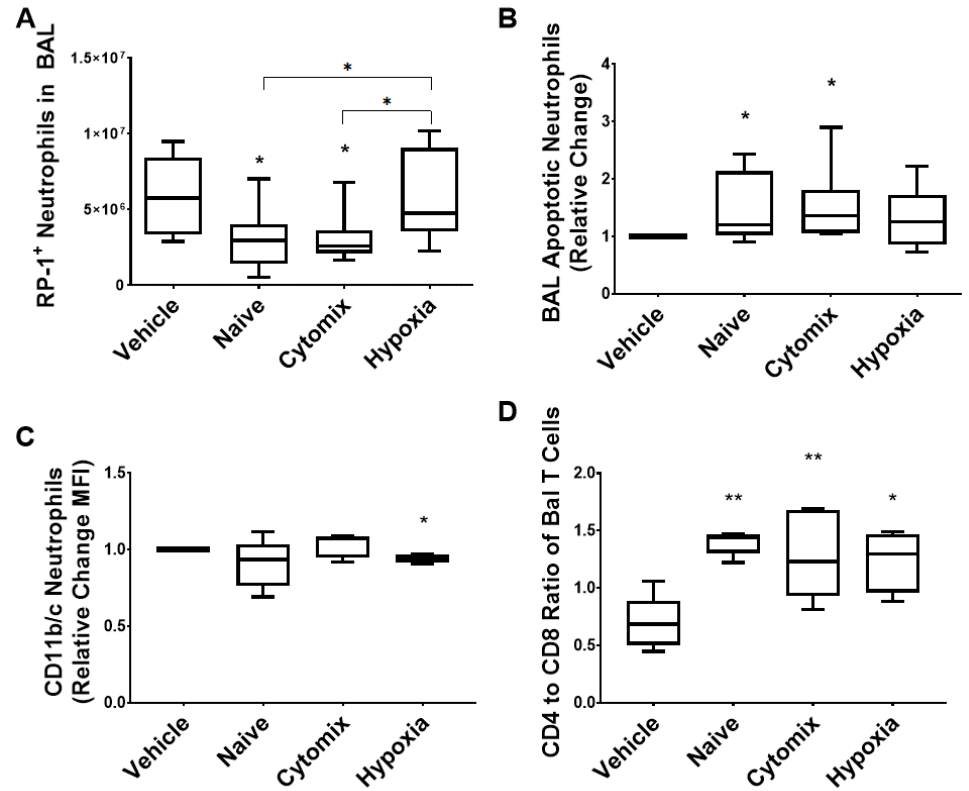
Figure 6. Flow cytometry analysis revealed that the total number of RP-1 + neutrophils present in the BAL fluid was significantly reduced in animals treated with naïve and cytomix-pre-activated MSCs compared to the control ( A ). The number of these neutrophils undergoing apoptosis was increased in the BAL fluid of animals treated with naïve or cytomix-pre-activated cells ( B ), and the number of activated neutrophils was slightly reduced by the application of naïve and hypoxia-pre-activated cells ( C ). CD4 + T helper cells in the BAL fluid remained largely unchanged across the groups ( D ), whereas the number of CD8 + cytotoxic T cells appeared to be reduced ( E ). The CD4 to CD8 ratio revealed a significant increase in all MSC-treated groups ( F ). BAL = bronchoalveolar lavage. Box plots and whiskers represent the minimum, first quartile, median, third quartile, and maximum. *, ** = p ≤ 0.05, 0.01 with respect to the vehicle control. N = 8–12.